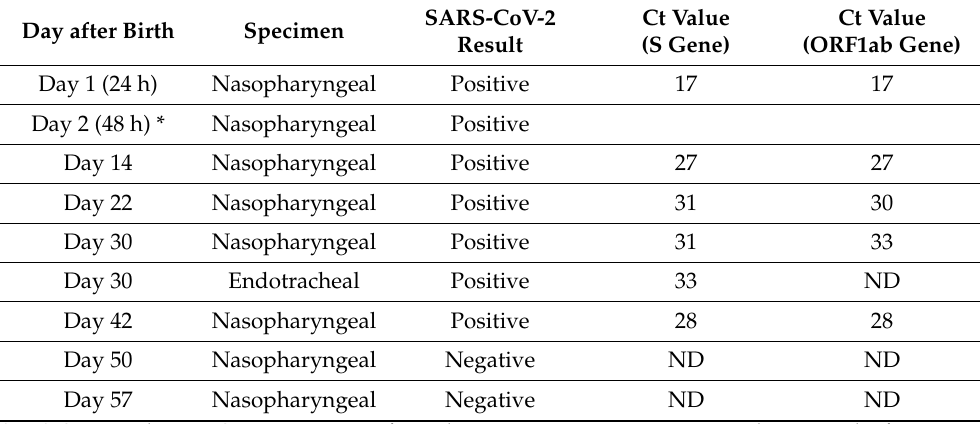
Table 1. SARS-CoV-2 test results and viral quantification by cycle threshold (Ct) values by real-time PCR over time. Day after Birth